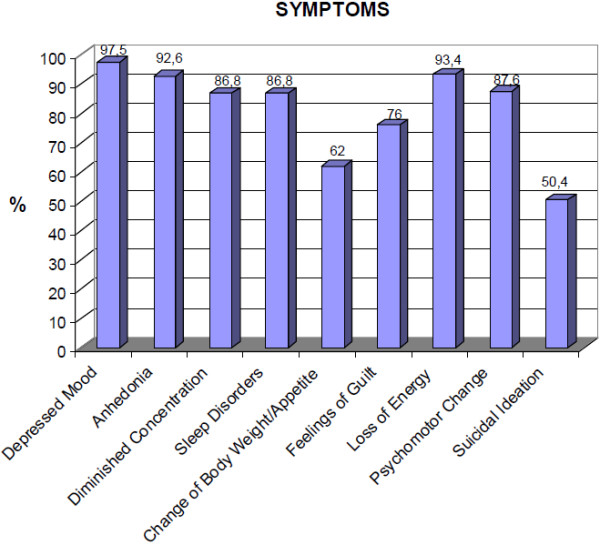
Prevalence of depressive symptoms in the studied patients.